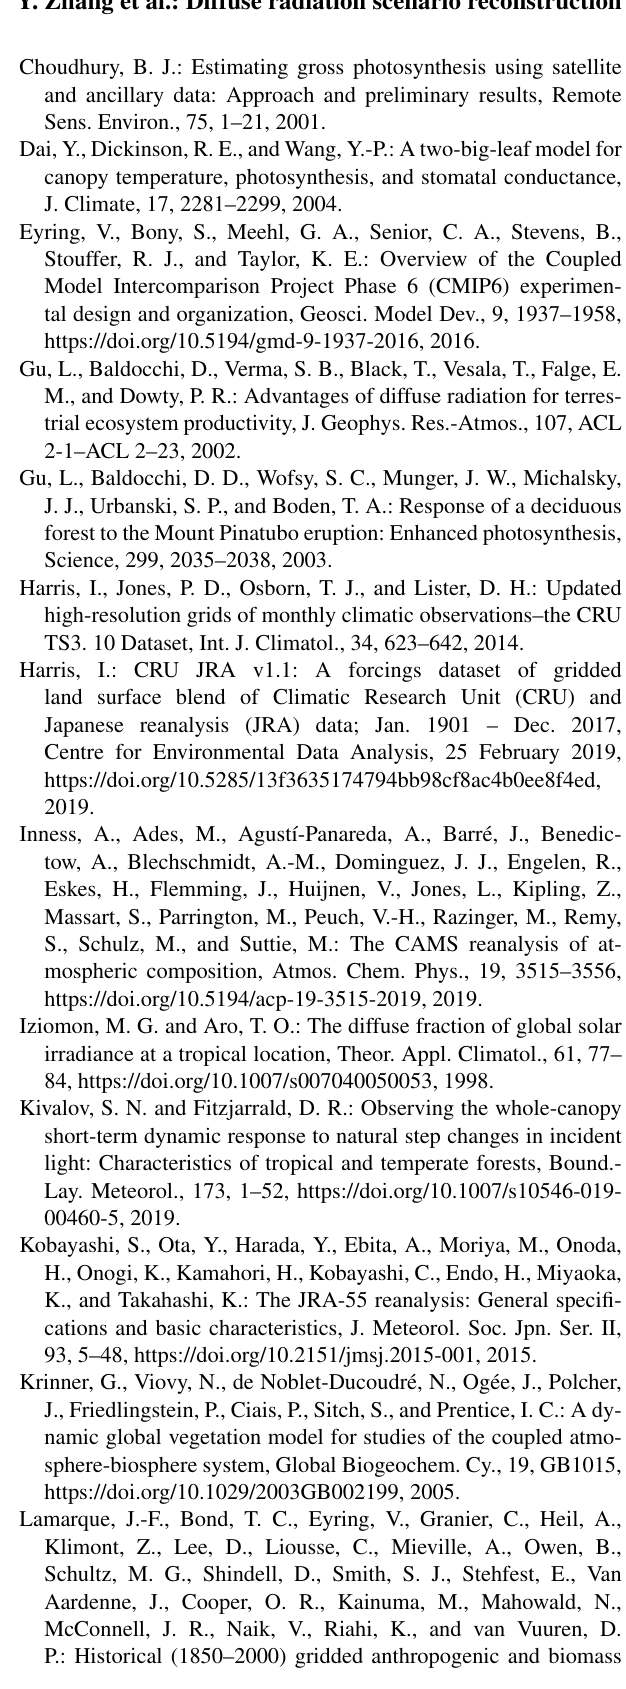
figshare Dataset,